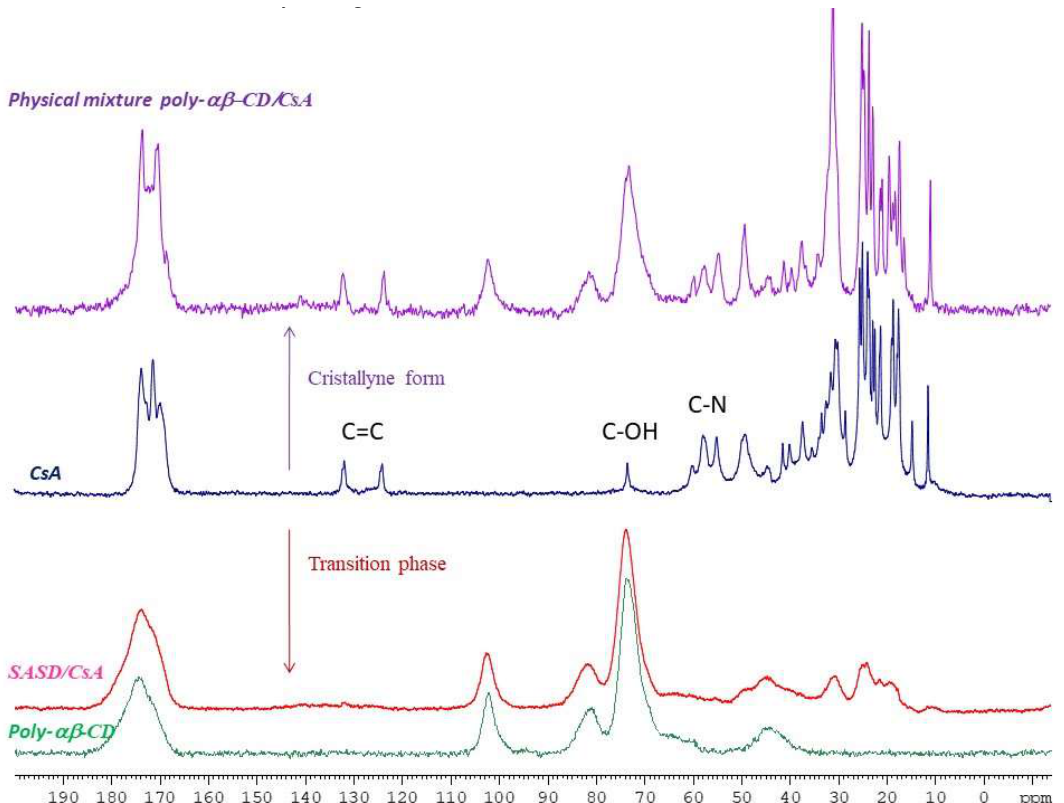
Figure 3. 13 C CPMAS NMR spectra of crystalline cyclosporine A (CsA; blue color), Poly- αβ -CD (green color), physical mixture of Poly- αβ -CD/CsA (purple color), and spherical amorphous solid dispersion based on Poly- αβ -CD copolymer of CsA (SASD/CsA; red color) as indicated in the diagram.